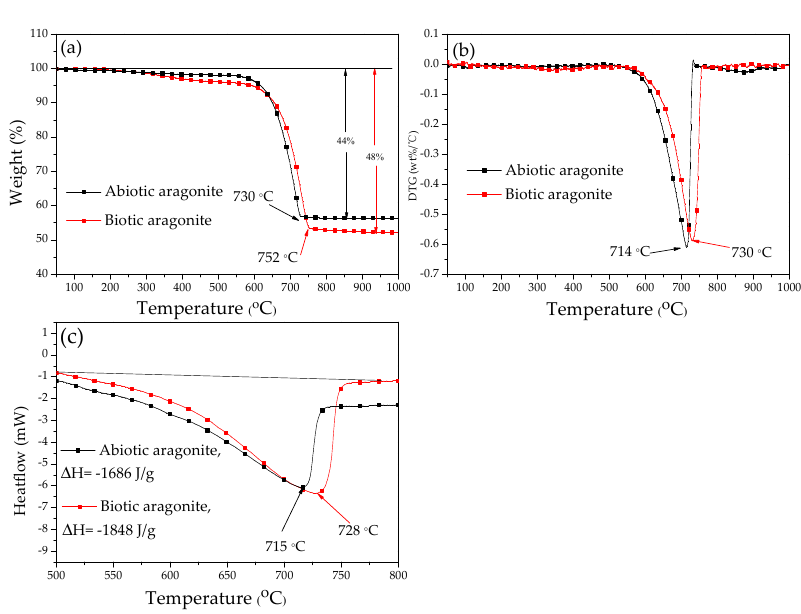
Figure 7. TG( a ), DTG( b ), and DSC( c ) analyses of the abiotic and biotic aragonite at a heating rate of 10 °C min − 1